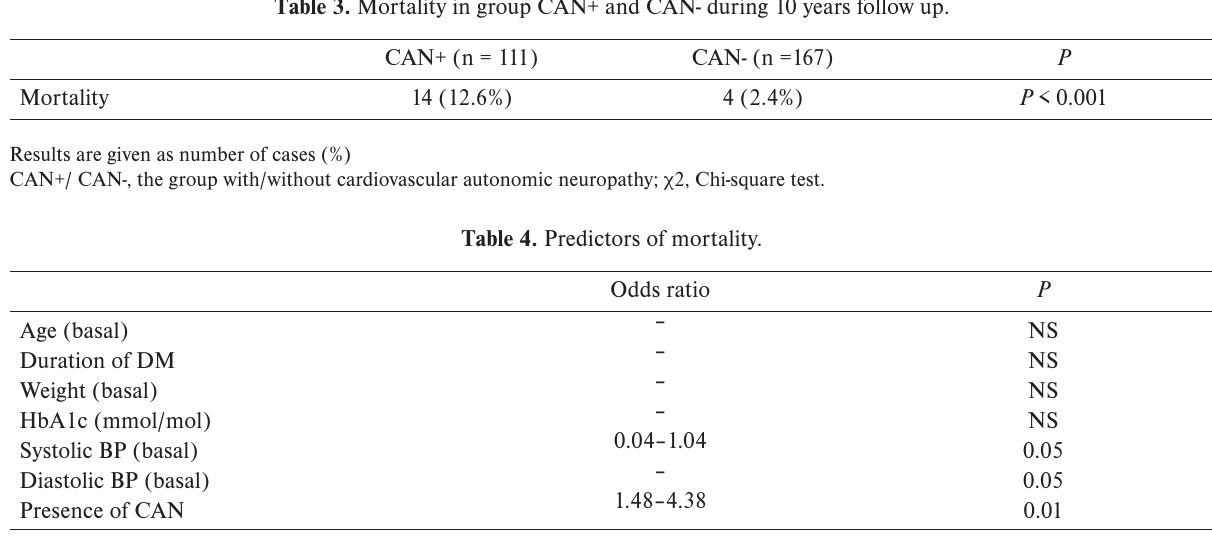
Table 3. Mortality in group CAN+ and CAN- during 10 years follow up.